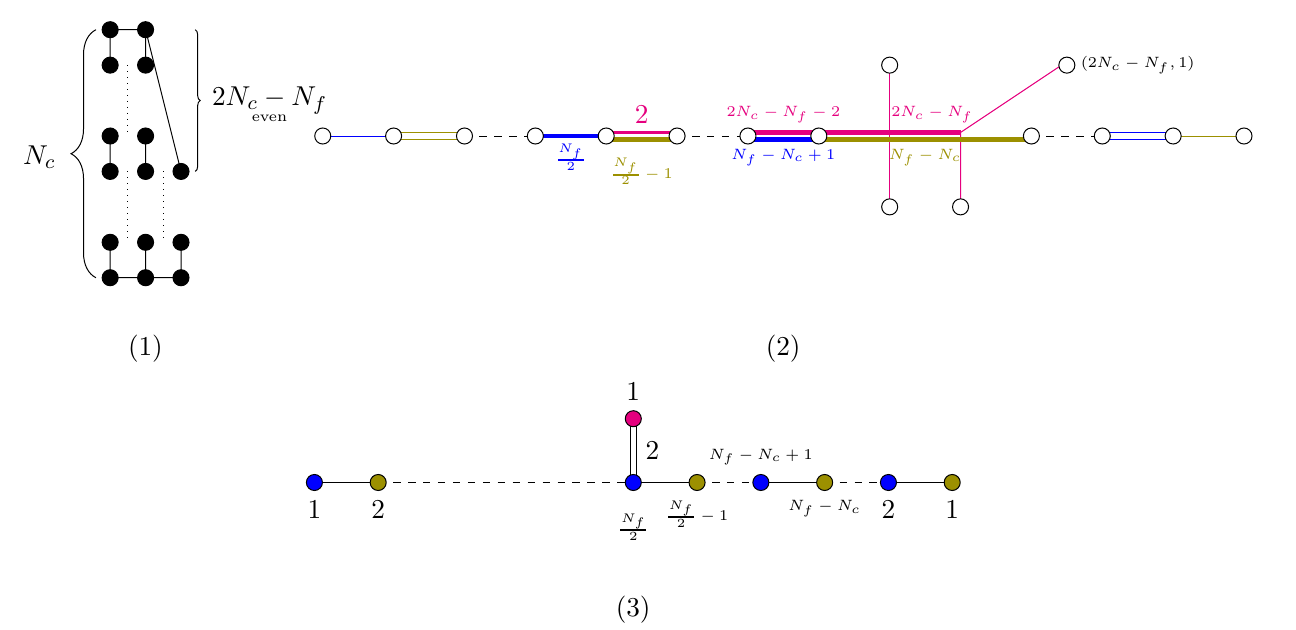
Figure 12 . (1) Toric Diagram representing SQCD with N c < N f < 2 N c Brane Web indicating the Mesonic cone of the Higgs Branch (3) magnetic Quiver whose 3d Coulomb Branch is the Mesonic cone of the Higgs Branch of our